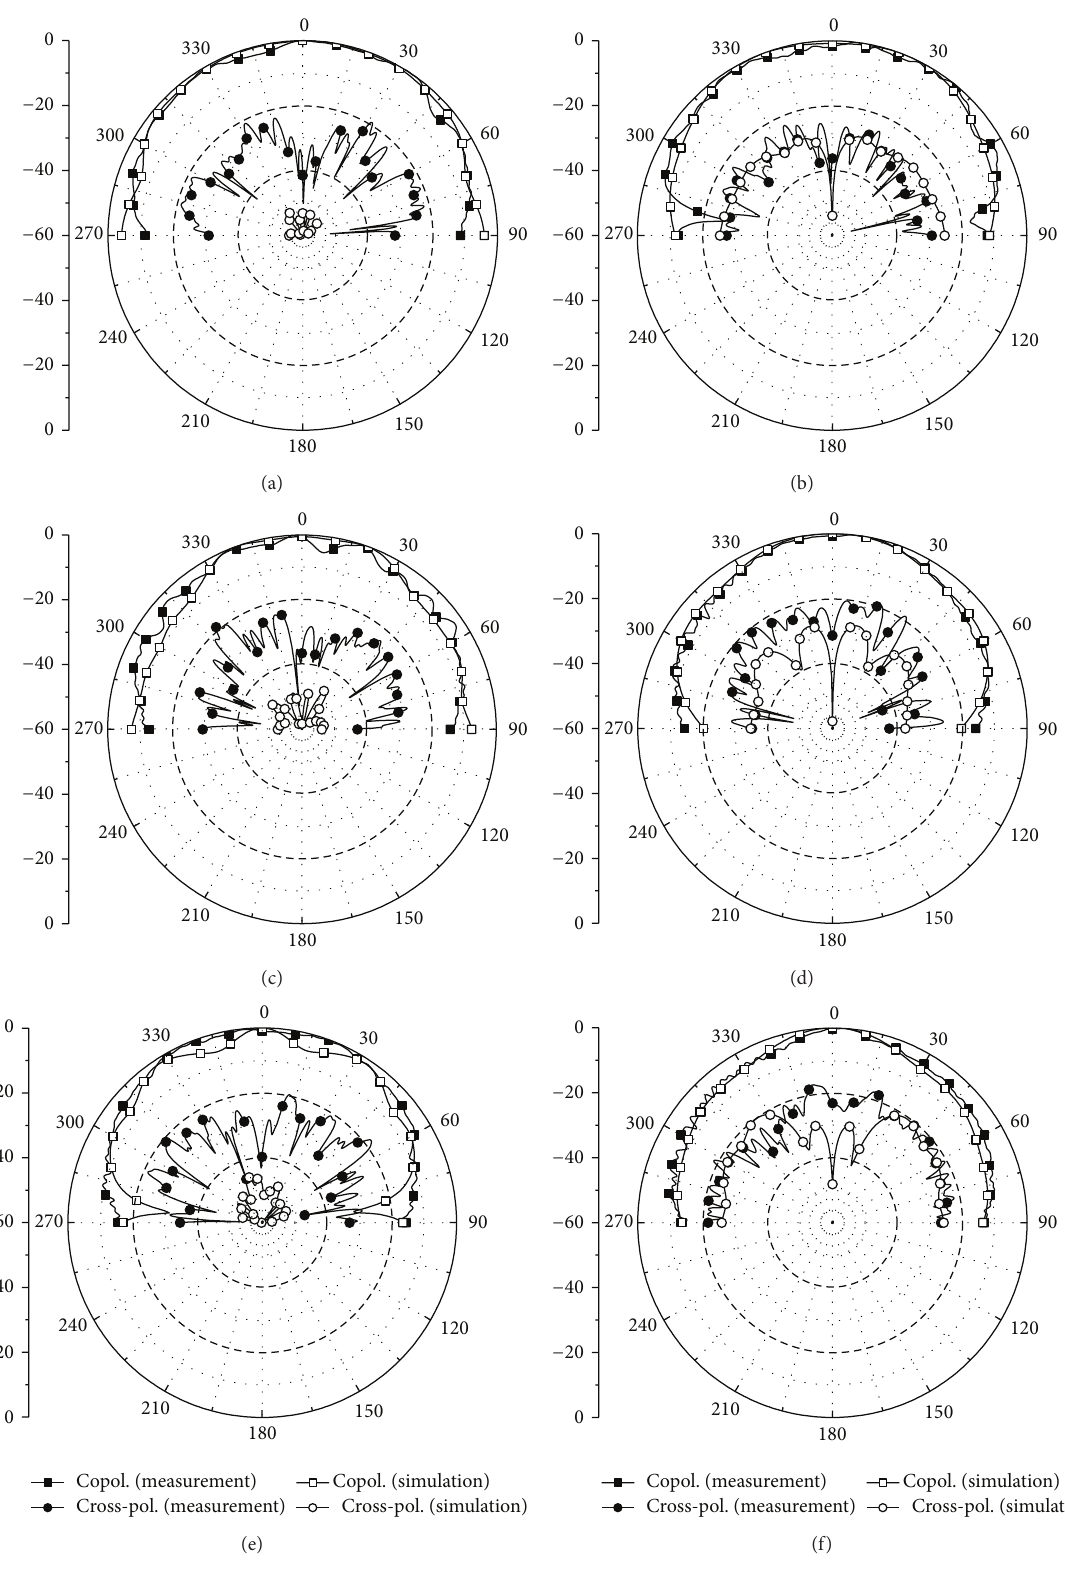
Figure 6: Measured and simulated radiation patterns of the central element at different frequencies. (a) E plane at 12 GHz. (b) H plane at 12GHz. (c) E plane at 15 GHz. (d) H plane at 15 GHz. (e) E plane at 18 GHz. (f) H plane at